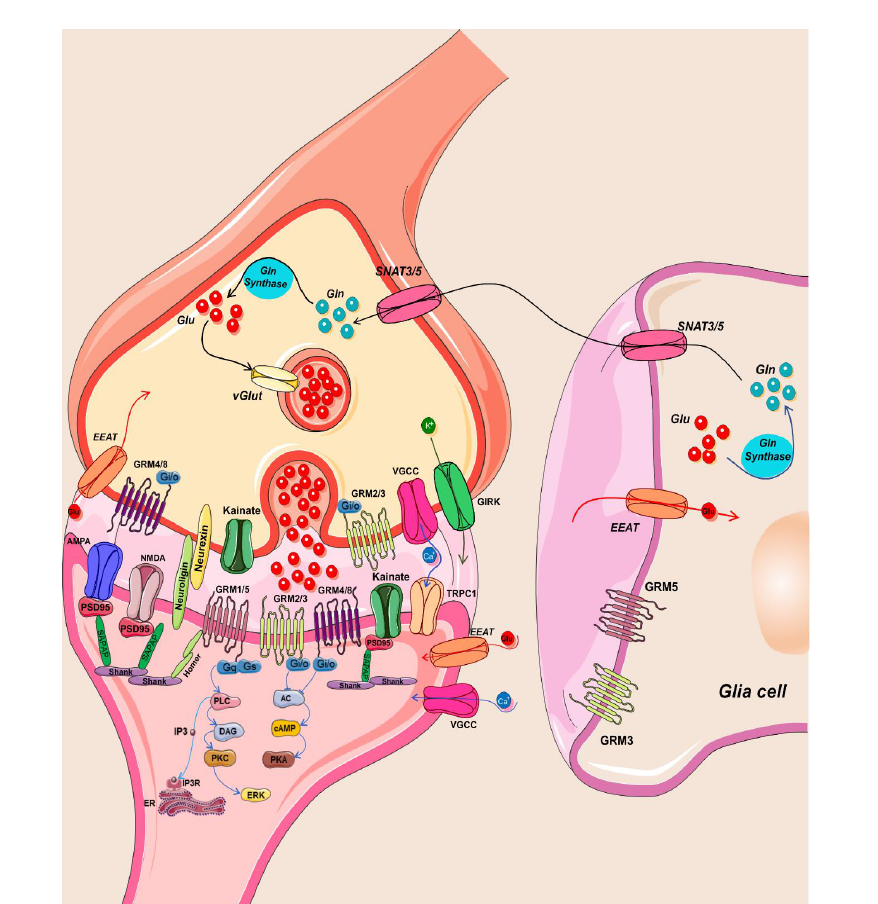
Figure 2. Schematic drawing of the glutamatergic synaptic pathway altered in ASD. Once released, glutamate can bind to and activate AMPA, Kainate, and NMDA ionotropic receptors or G-protein coupled metabotropic receptors on postsynaptic or presynaptic neurons as well as glial cells. Glutamate, taken up into glial cells by EAAT1/2 glutamate transporters, is converted into glutamine, which can be transported into glutamatergic neurons by SNAT3/5 transporters.